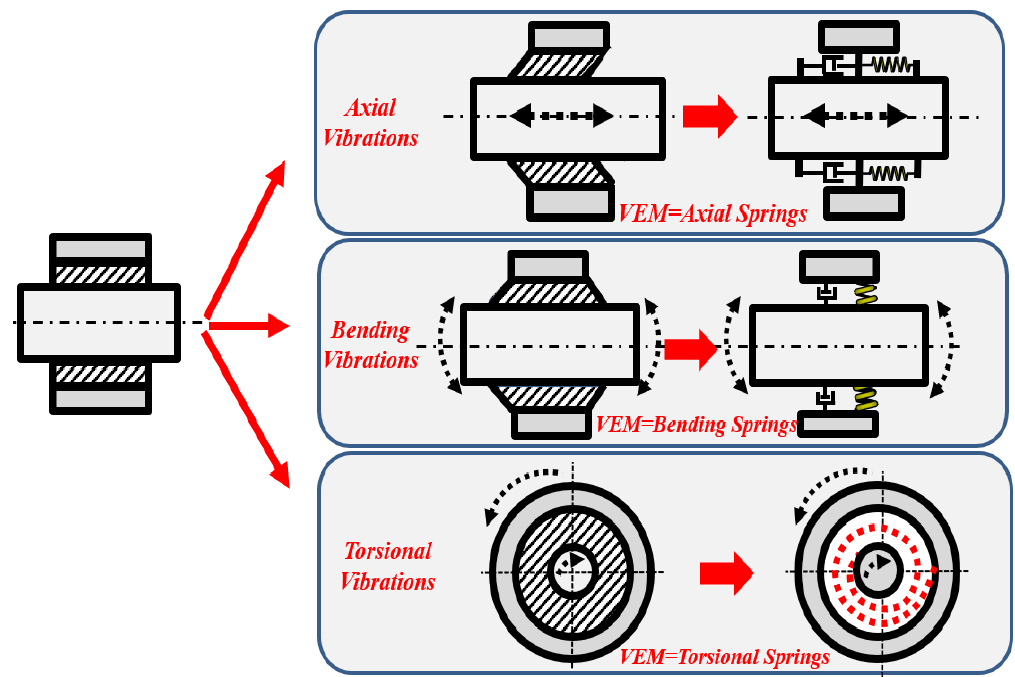
Figure 2. Simultaneous control of torsional, axial, and transverse bending vibrations of drill-string with periodic sources of local resonance ( VEM: Visco-elastic material).